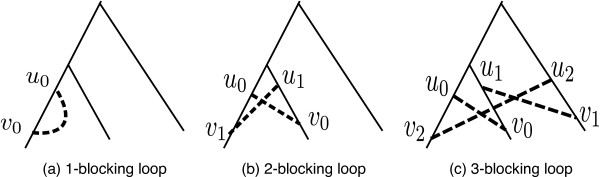
Blocking Loops. Blocking loops of size 1, 2 and 3. The solid lines represent a subset of the tree T. The dashed lines are non-tree edges representing interaction flip events.